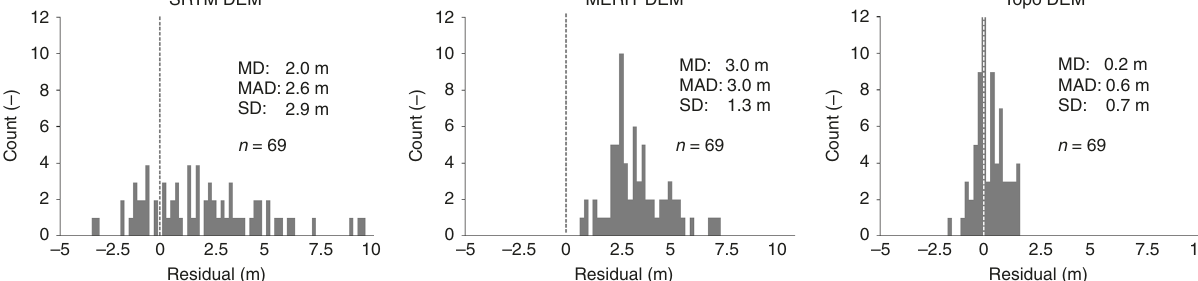
Fig. 4 Elevation offsets between elevation models and national benchmarks. Histograms of elevation differences between the SRTM, MERIT, and the Topo Digital Elevation Models (DEMs) and national benchmarks in the Mekong delta. A positive residual means DEM elevation exceeds benchmark elevation. MD = mean deviation (difference in means), MAD = mean absolute deviation (mean of individual differences), SD = standard deviation of